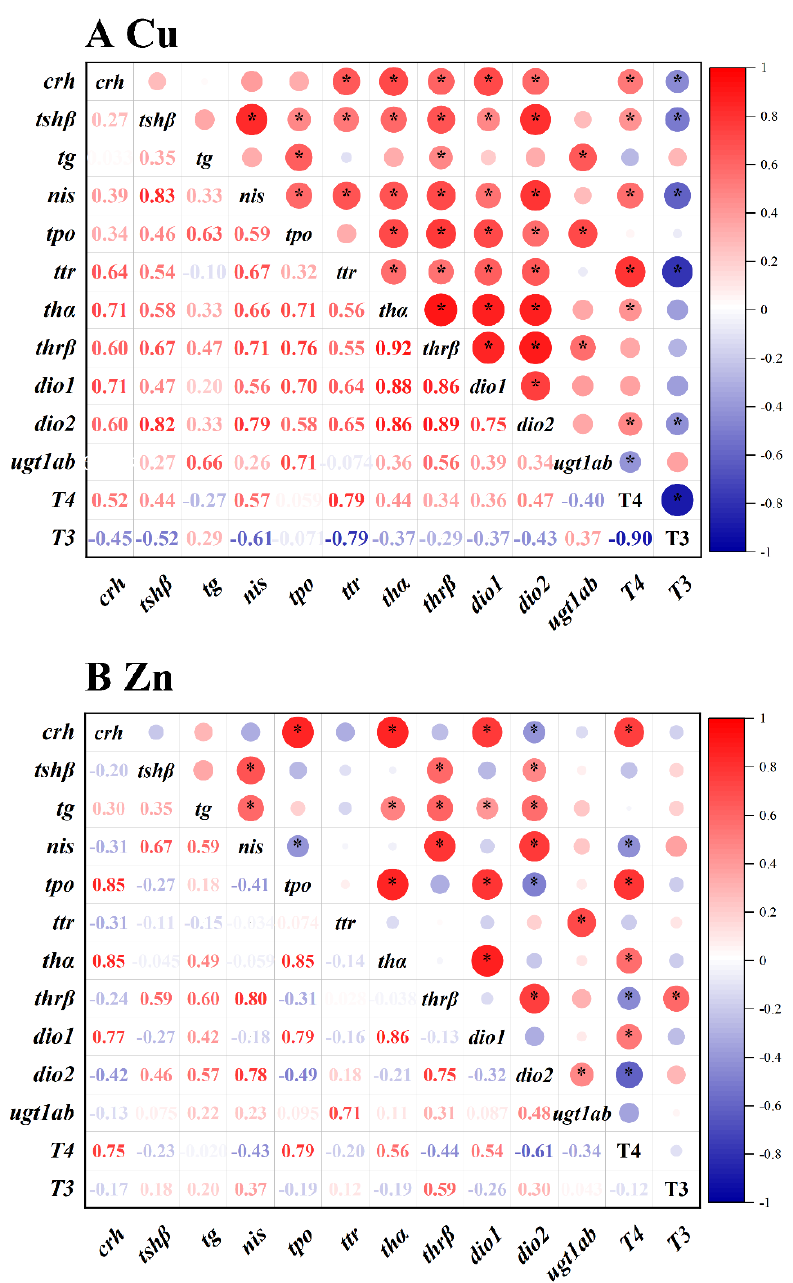
Figure 4. Heatmap of correlation coefficients between the THs (T4 and T3) contents and the gene expression levels in the zebrafish embryos/larvae that were treated with Cu 2+ (0, 1.5, 15 and 150 μg/L) ( A ) and Zn 2+ (0, 20, 200 and 2000 μg/L) ( B ) for 120 h. The scale indicates the level of positive (red) or negative (blue) correlation, and * indicates significance (* p < 0.05).